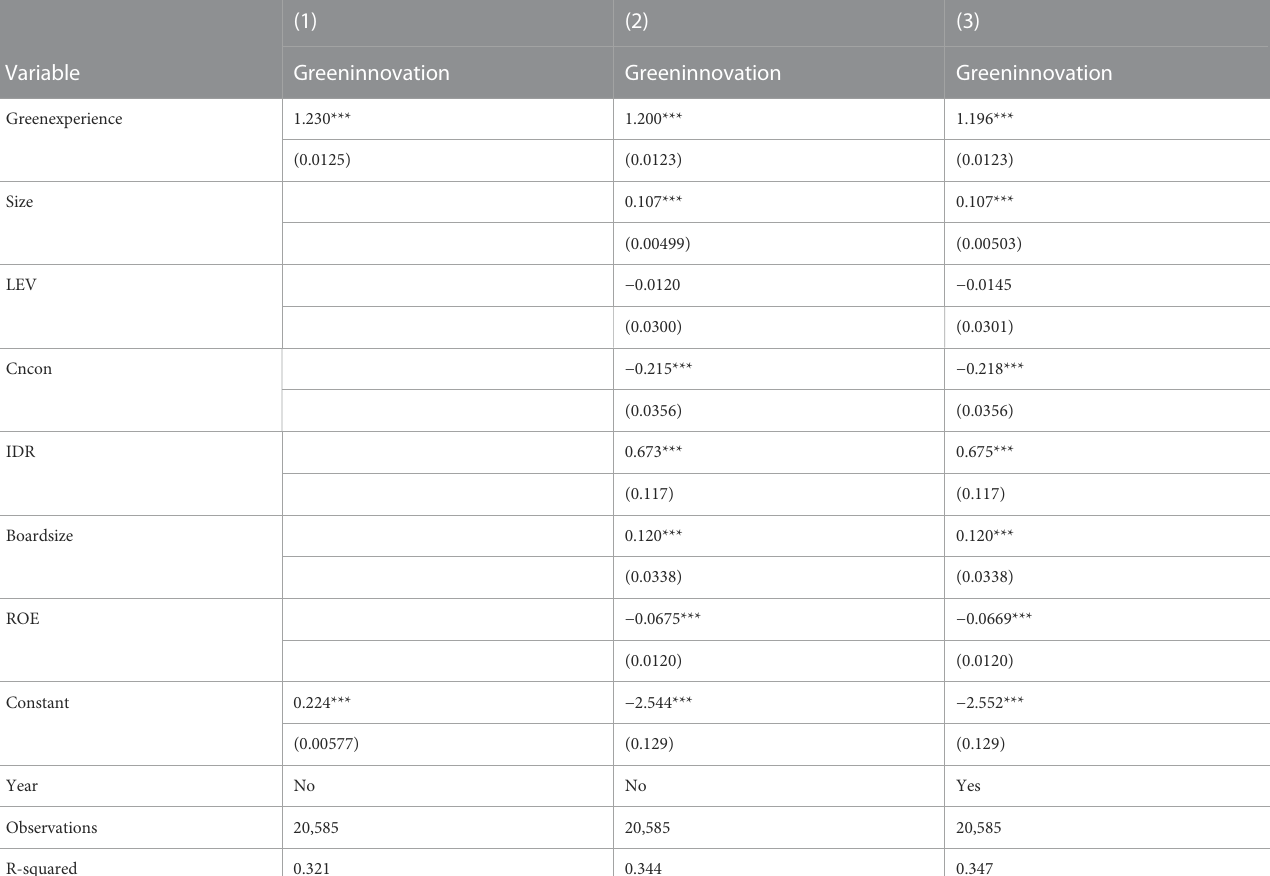
TABLE 4 Regression results of CEO ’ s green ecological experience and green